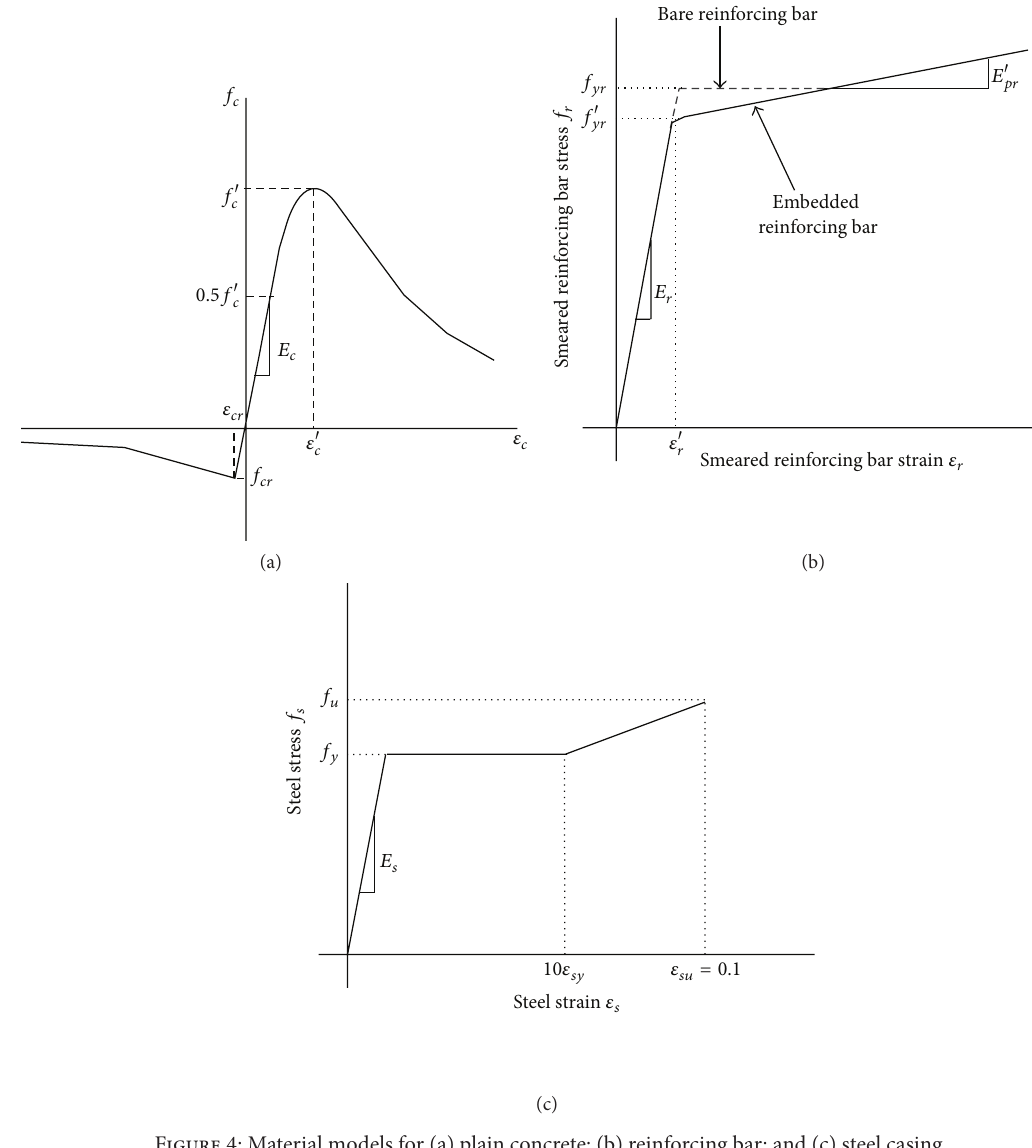
Figure 4: Material models for (a) plain concrete; (b) reinforcing bar; and (c) steel casing.